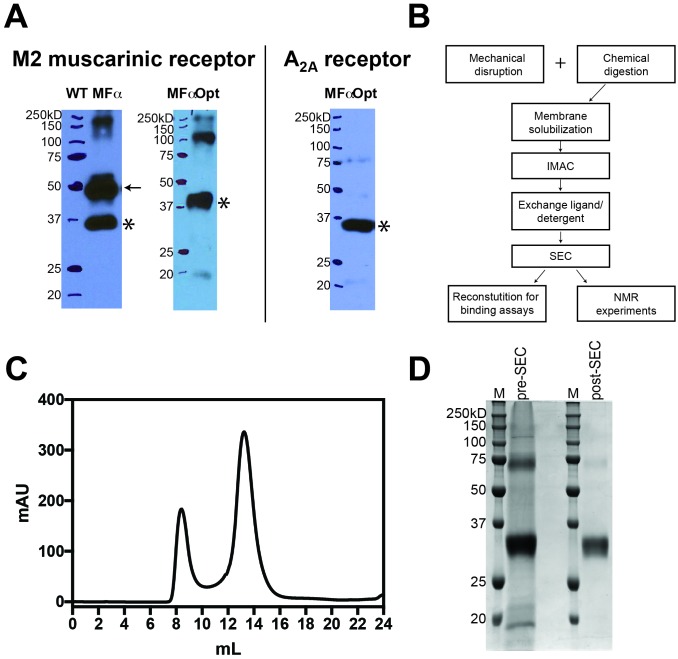
A2AR processing and purification.(A) Anti-His6 Western blots of wild-type GPCRs expressed in Pichia as a fusion with the wild-type (WT) and optimized (MFαOpt) α-mating factor secretion signal. Receptor that has not been fully processed and trafficked to the plasma membrane is marked with an arrow. Fully processed, mature receptor is marked with an asterisk. (B) Purification scheme of A2AR from Pichia cultures. (C) Gel filtration trace of IMAC-purified A2AR injected on a Superdex200 10/300 column. The void volume is 8.3 mL and monomer A2AR elutes at approximately 13.7 mL. (D) SDS-PAGE of IMAC-purified A2AR before and after size exclusion chromatography shown in C).